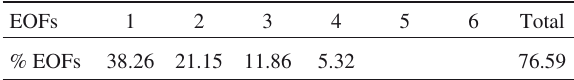
Table 1. – Variance explained for each EOF approximation. Using EOF with four EOFs